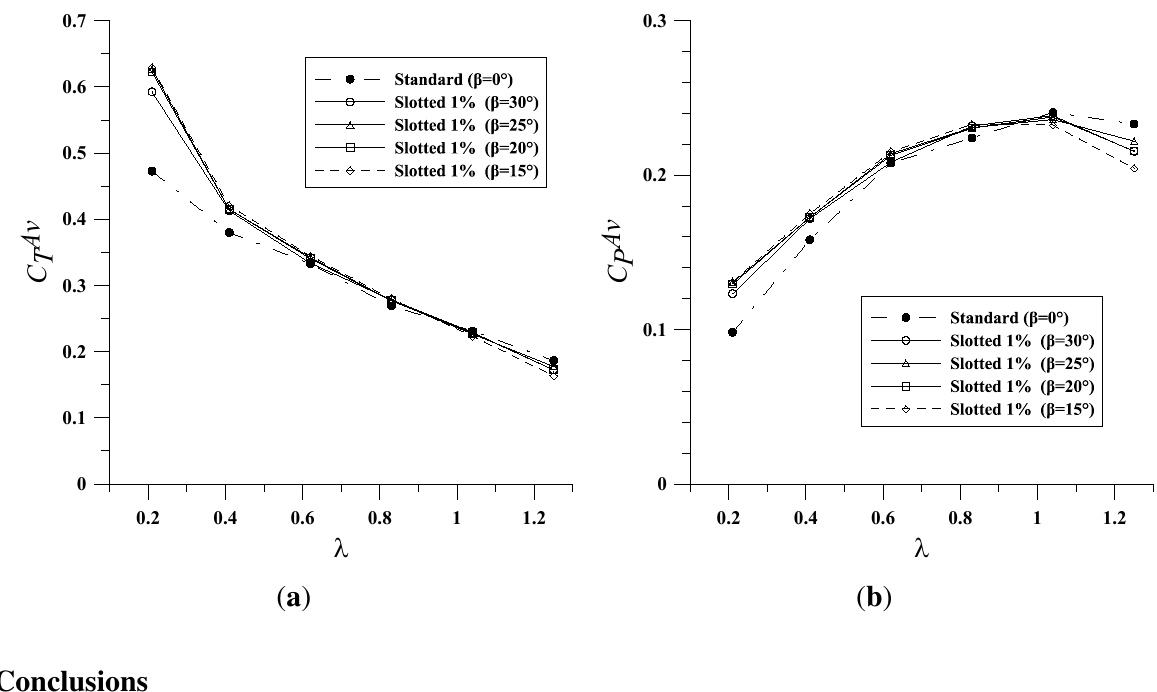
; and ( b ) C Av coefficients for f = 1% and different angle β T P